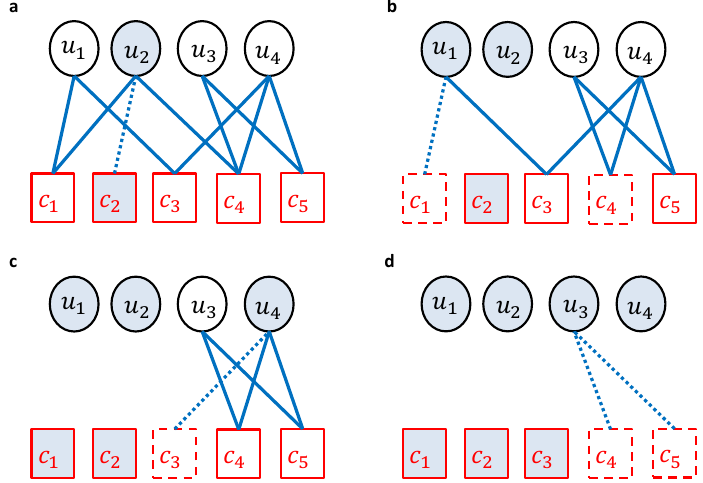
Figure 3. A toy example of an LT decoding process, where there are 4 source symbols (circles) and 5 encoded symbols (squares). Figures from ( a – d ) show the decoding steps of the